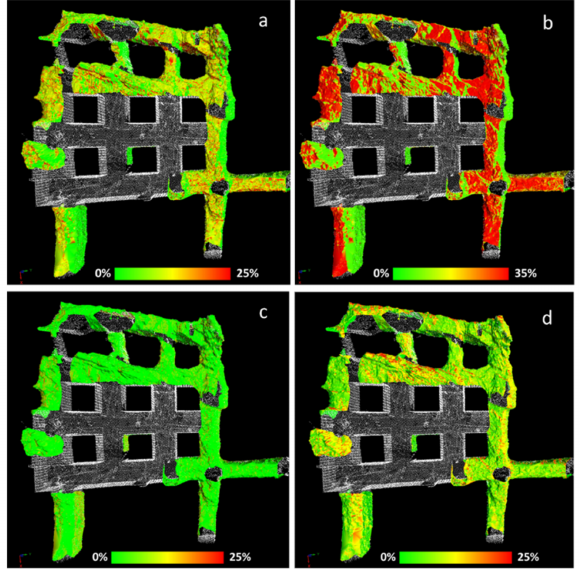
Figure 18. Kinematic analysis: ( a ) planar failure mechanism; ( b ) wedge failure; ( c ) toppling